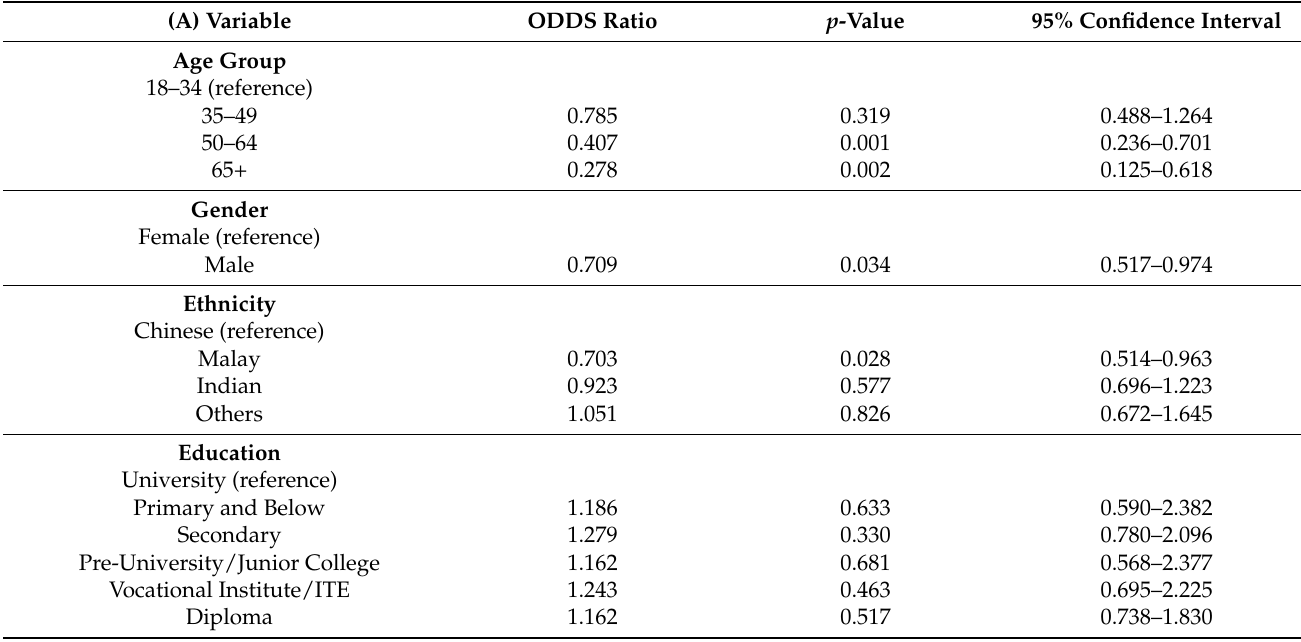
Table 2. ( A ). Socio-demographic factors of suicidal ideation. ( B ). Associations among suicidal ideation, physical, and mental